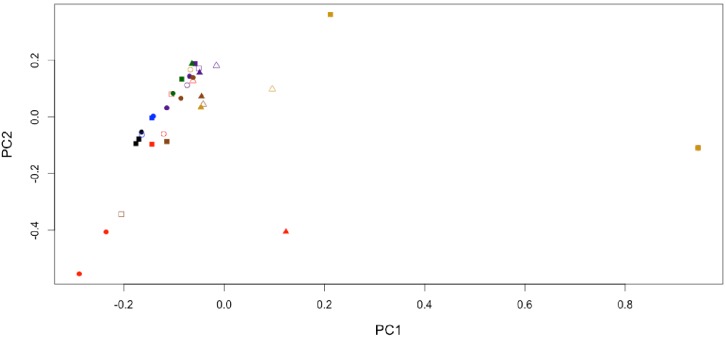
Non-normalised PCA of THAA composition.prcomp() function in R scale set to ‘FALSE’. Color and shape coding identical to that in Appendix 1—figure 24.